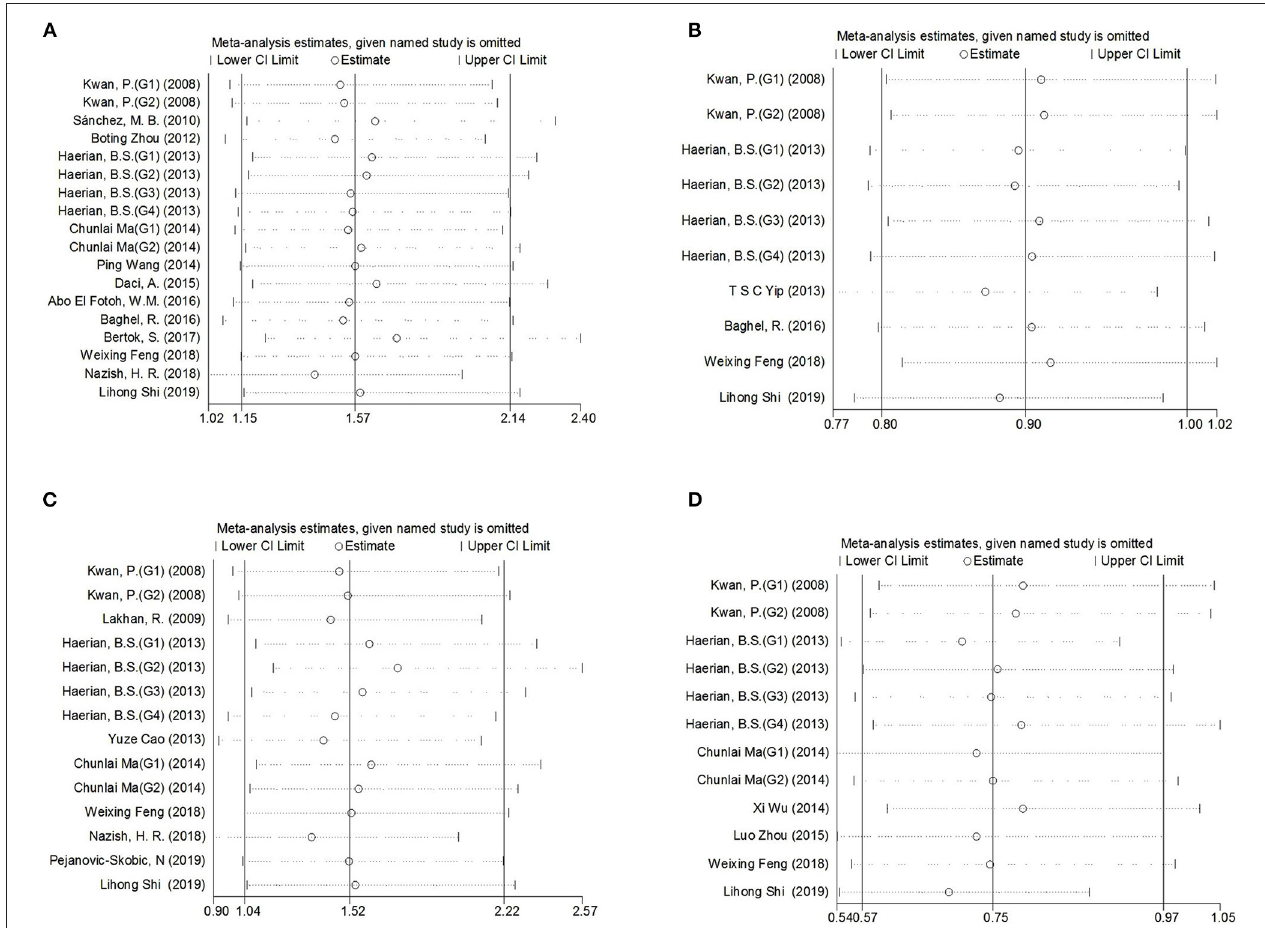
FIGURE 3 | Sensitivity analysis indicated the stability of the results. (A) SCN1A rs2298771 polymorphism (GG vs. AA). (B) SCN1A rs10188577 polymorphism (C vs. T). (C) , SCN2A rs17183814 polymorphism (AA vs. GG). (D) , SCN2A rs2304016 polymorphism (G vs. A).